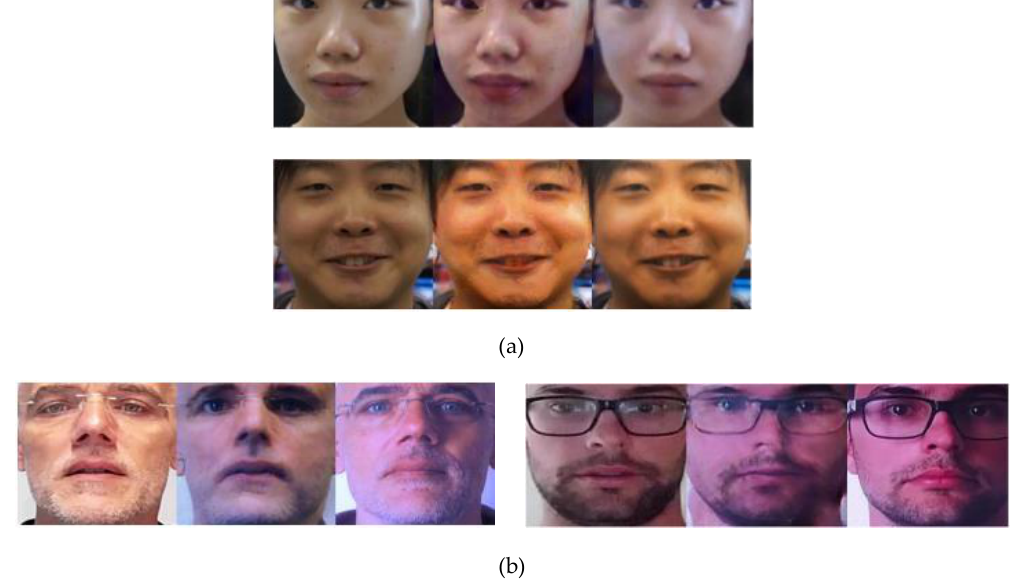
Figure 6. Examples of generated images using the trained generation model: ( a ) Images in the CASIA dataset. ( b ) Images in the Replay-mobile dataset. In each trio of images, the left, middle, and right images represent the real image, generated PA image, and reference PA image, respectively.